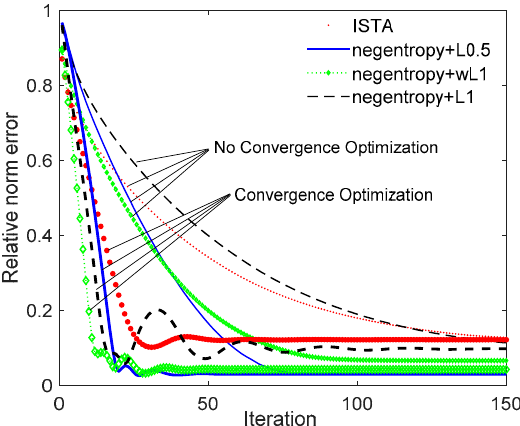
Figure 5. Relative norm error performance versus iterations.